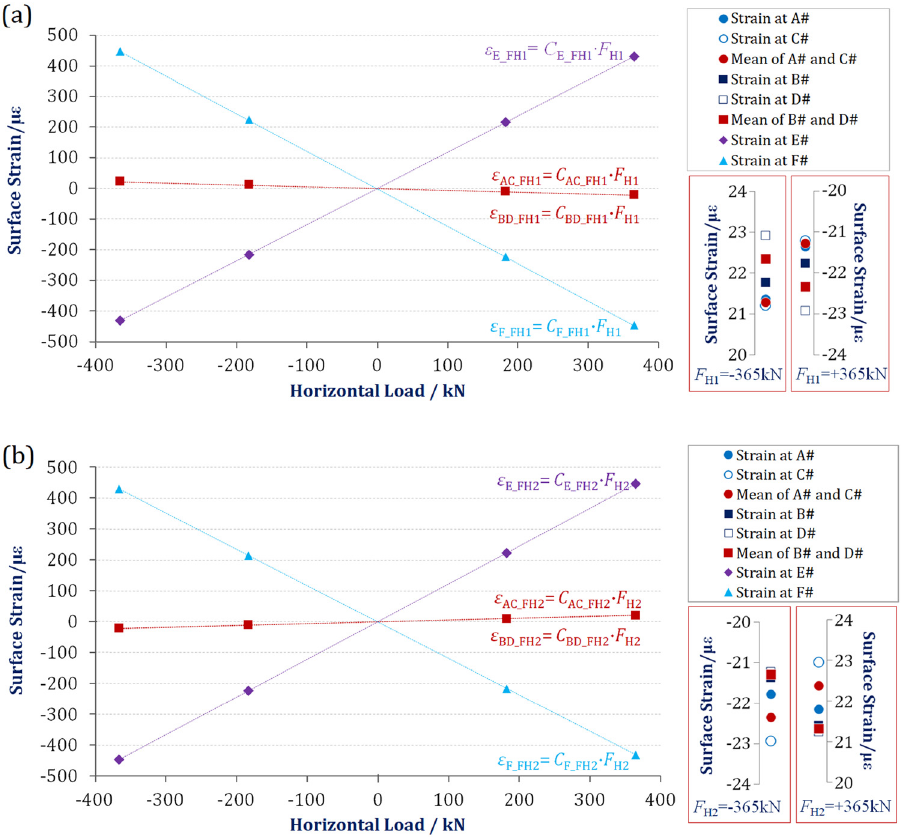
Figure 8: Surface strain response under horizontal loading at individual jack rod: ( a ) load at jack rod 1# and ( b ) load at jack rod